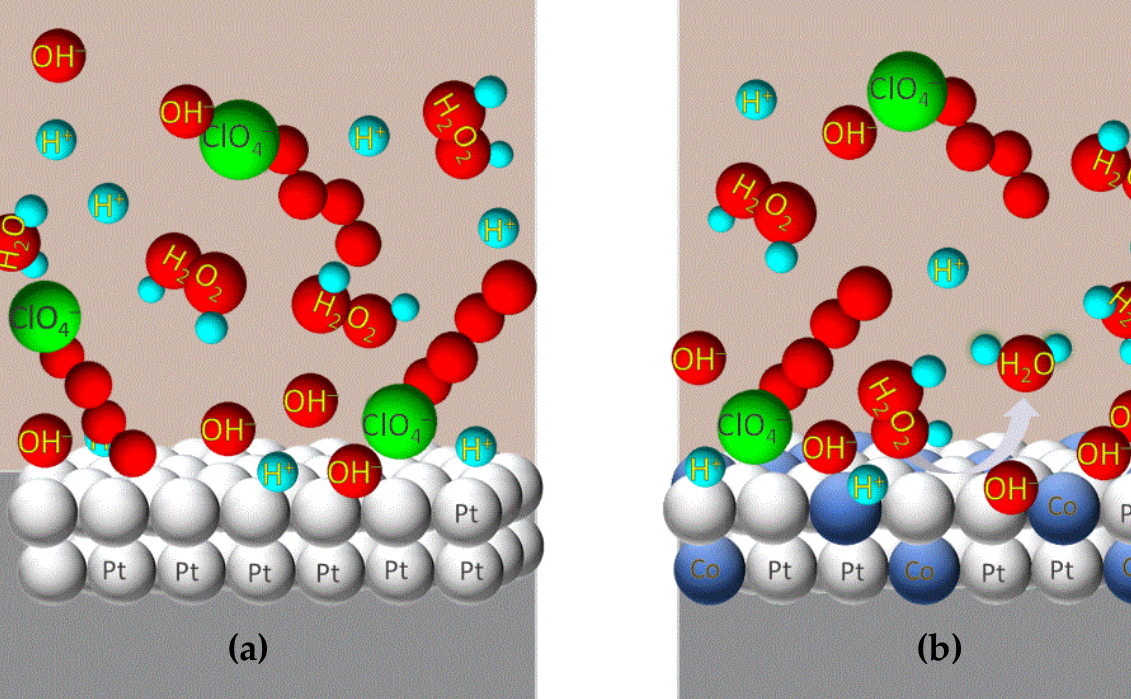
Figure 3. The catalysis of platinum on H 2 O 2 reduction is constrained by the constant presence of adsorbed species on its surface ( a ). The presence of second metal in the electrode structure with the consequent alteration of the binding force of adsorbed species on the electrode surface results in a significant increase in active sites number for the catalysis of H 2 O 2 cathodic reaction into H 2 O ( b ).